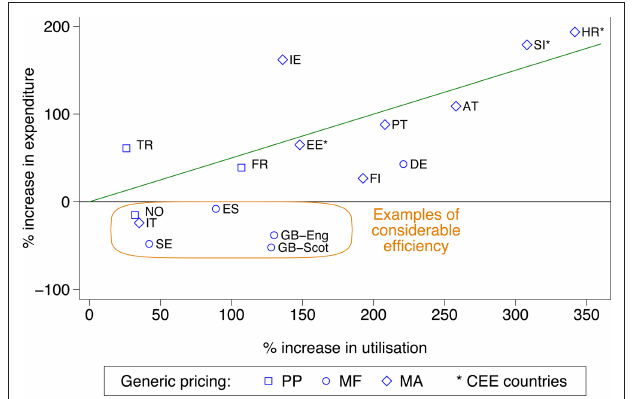
FIGuRE 2 | Percentage change in utilization (DDDs) versus the percentage change in reimbursed expenditure (local currency) for the statins principally from 2001 to 2007 among European countries. The countries again divided into former Central and Eastern European countries (CEE) with the approaches to generic pricing divided into three categories. Standard EU country abbreviations have been used. ES = Catalonia (2007 versus 2003), EE = 2007 versus 2004, HR = 2007 versus 2000, IT = 2008 versus 2006, NO = 2007 versus 2004, TR = 2009 versus